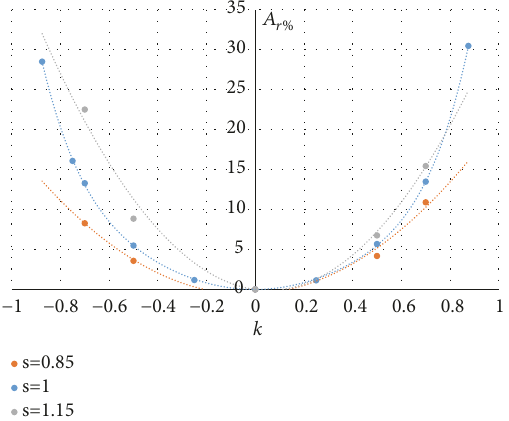
Figure 11: Trend of the mean value of R when k and s vary.